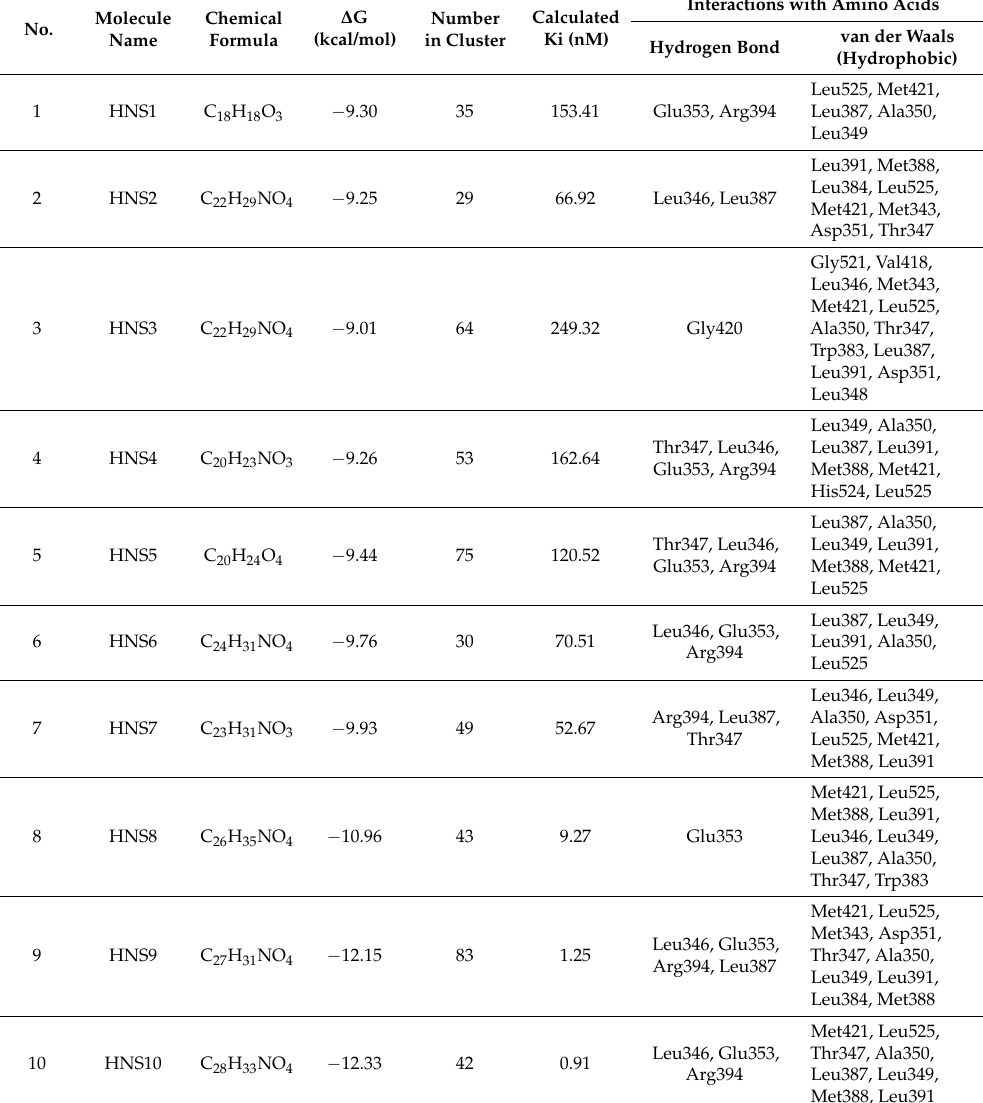
Table 3. Results of molecular docking simulation of ChalcEA derivatives in ligand binding domain of estrogen receptor alpha (ER α